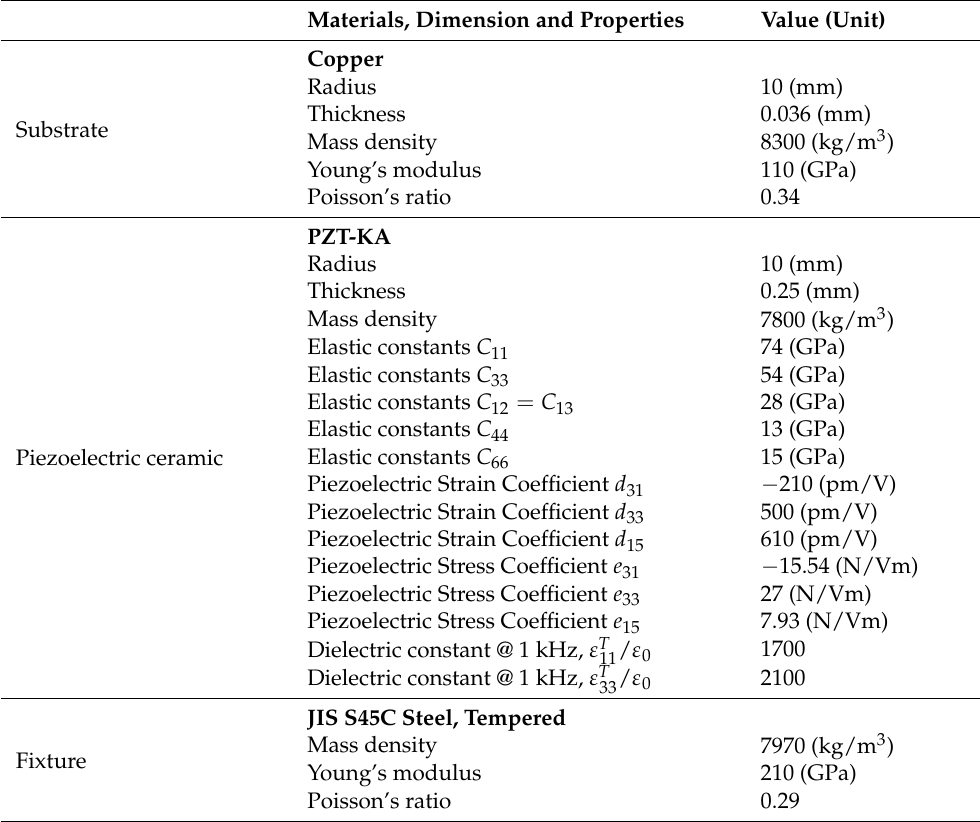
Table 2. Material, geometric, and electromechanical parameters of PT for analytical, finite element and experimental